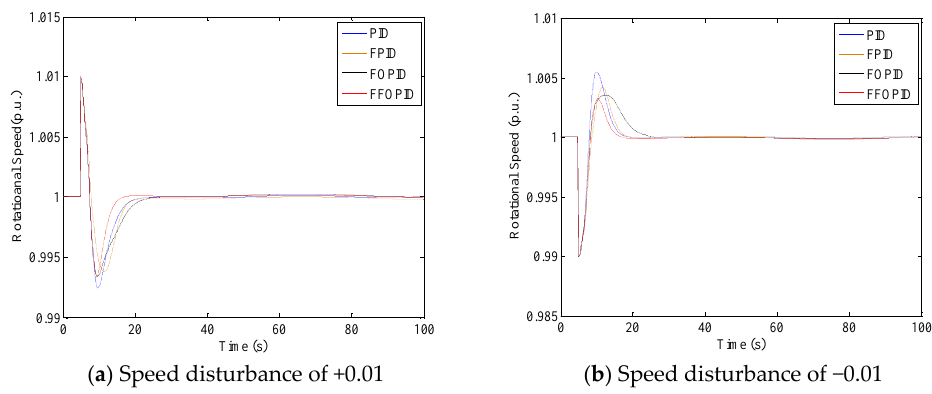
Figure 10. Optimal membership function by MOGSA.